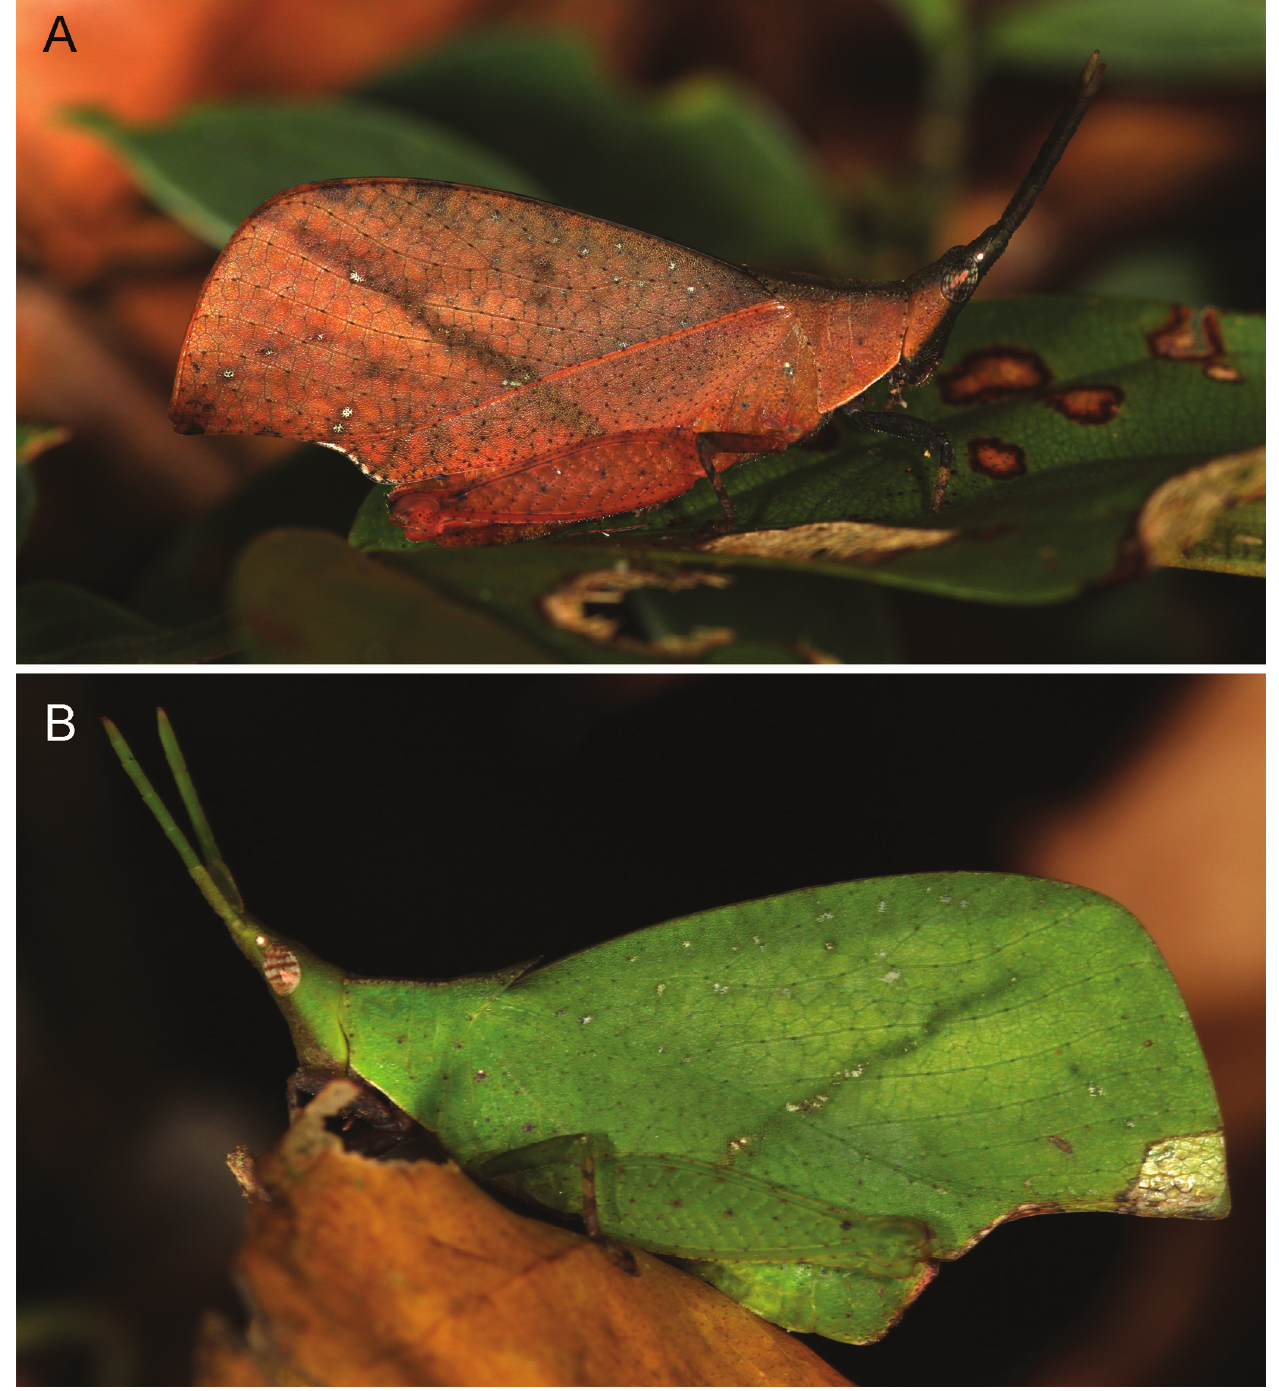
Fig. 7. Trigonopterygidae: Systella platyptera male